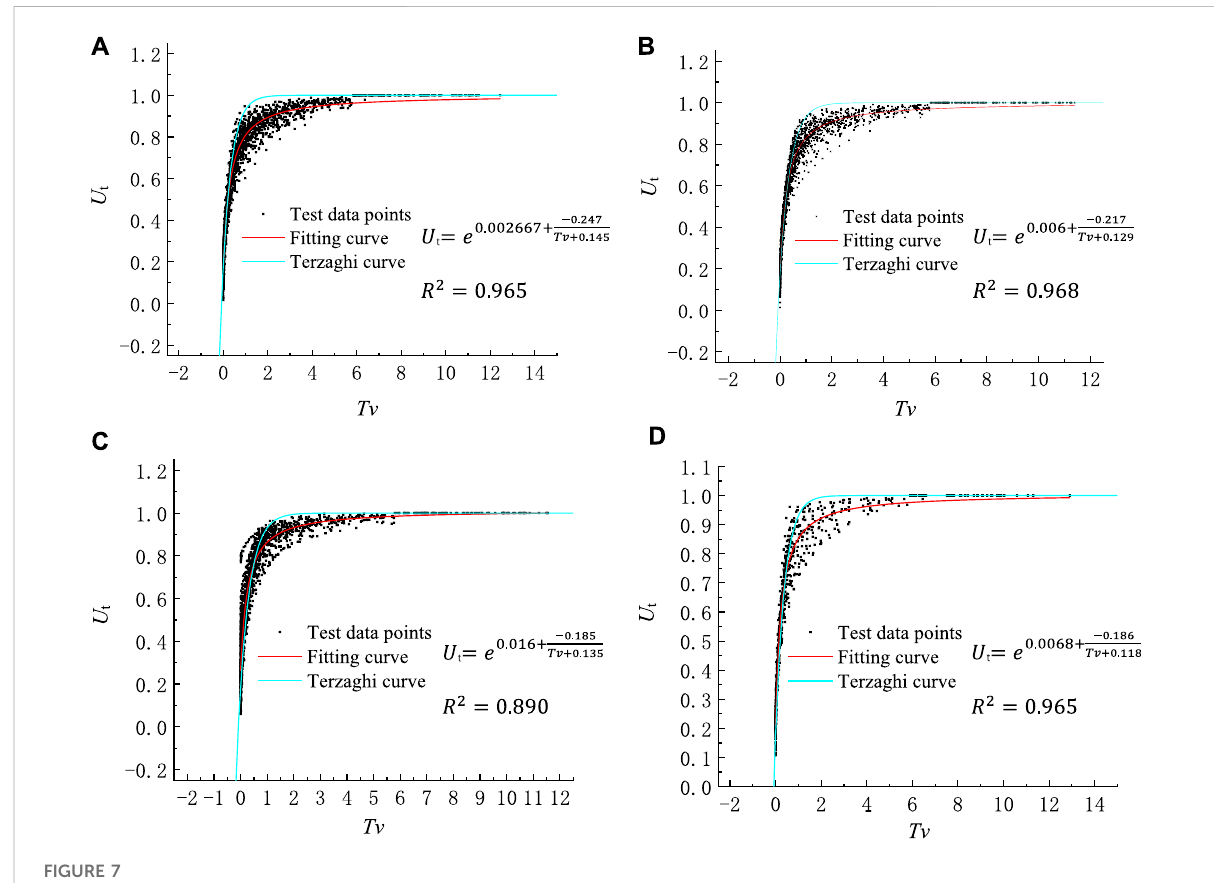
FIGURE 7 Data fi tting of U t - T v curves for the clayey soil samples at depth of 0 – 100 m under loads of 0.64 MPa (A) , 1.28 MPa (B) , 2.56 MPa (C) and 5.12Mpa (D)